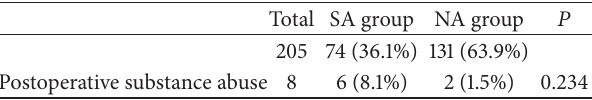
Table 3: Substance abuse recidivism after bariatric surgery in patients with and without a prior history of substance